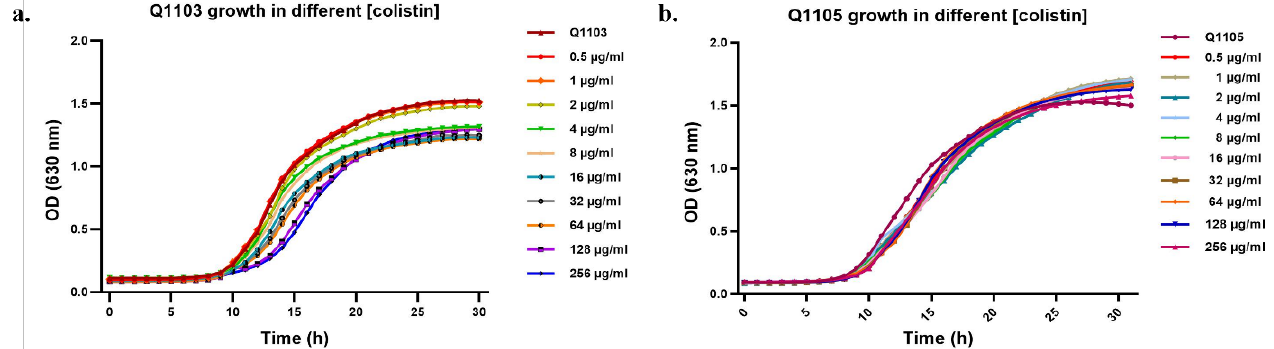
Figure 3. Growth of B. intermedia strains treated with different colistin (CO) concentrations. Growth of strain Q1103 was slightly affected by the increasing concentrations of CO ( p < 0.0388), while growth of the strain Q1105 was not affected ( p = 0.999).